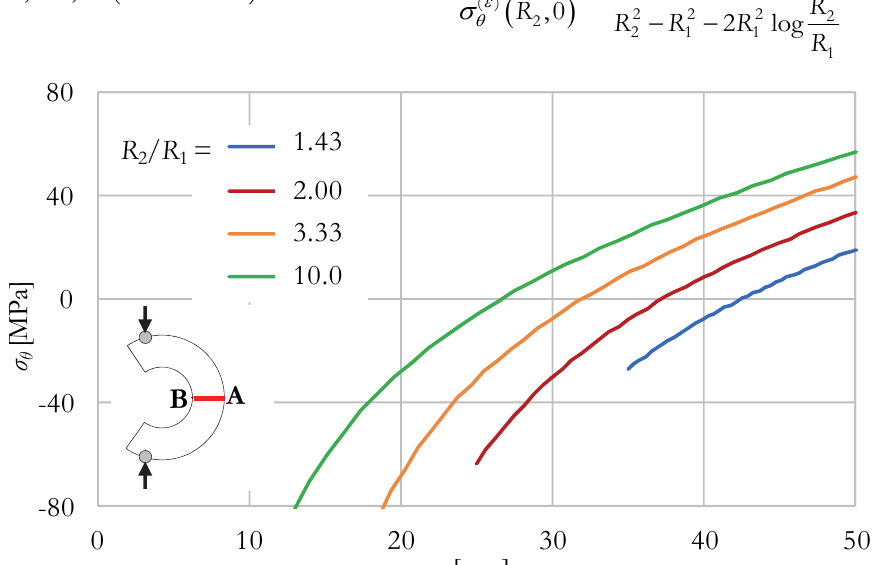
Figure 6: The distribution of the transverse normal stress along the axis of symmetry (locus AB) of the CSR for various ρ